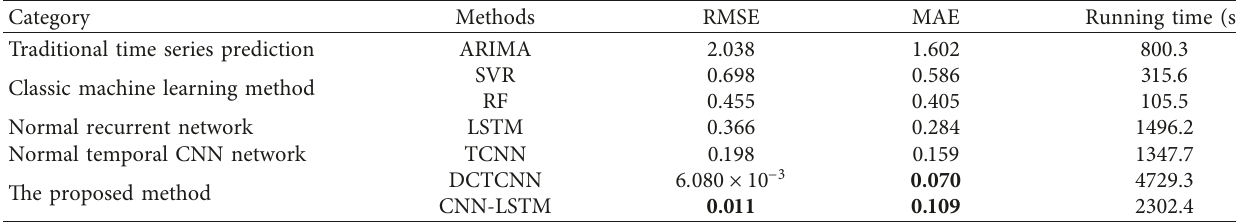
Table 3: Seven compared methods performance on AAIA ′ 16 seismic dataset.